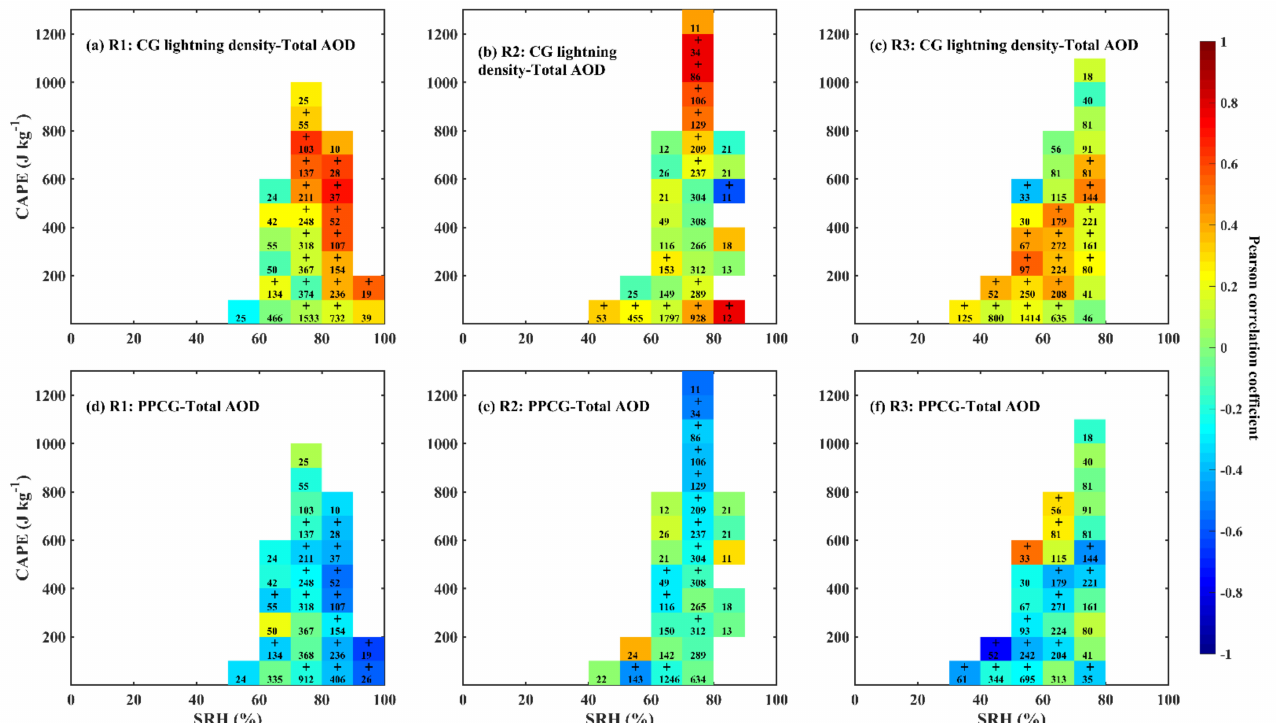
Figure 10. The Pearson correlation coefficients of ( a )~( c ) total AOD-CG lightning density and ( d )~( f ) total AOD-PPCG for various bins of CAPE and SRH over three study regions during 2010–2018. The number in each cell indicates the number of data points in the cell. Plus signs denote those cells that pass the significance test of 0.05. Data from all seasons are included. The data of CAPE and SRH are derived from ERA5, and AOD data are derived from